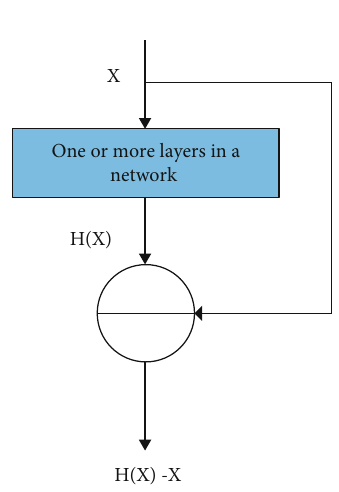
Figure 2: Learning style classi fi cation ICAP framework.